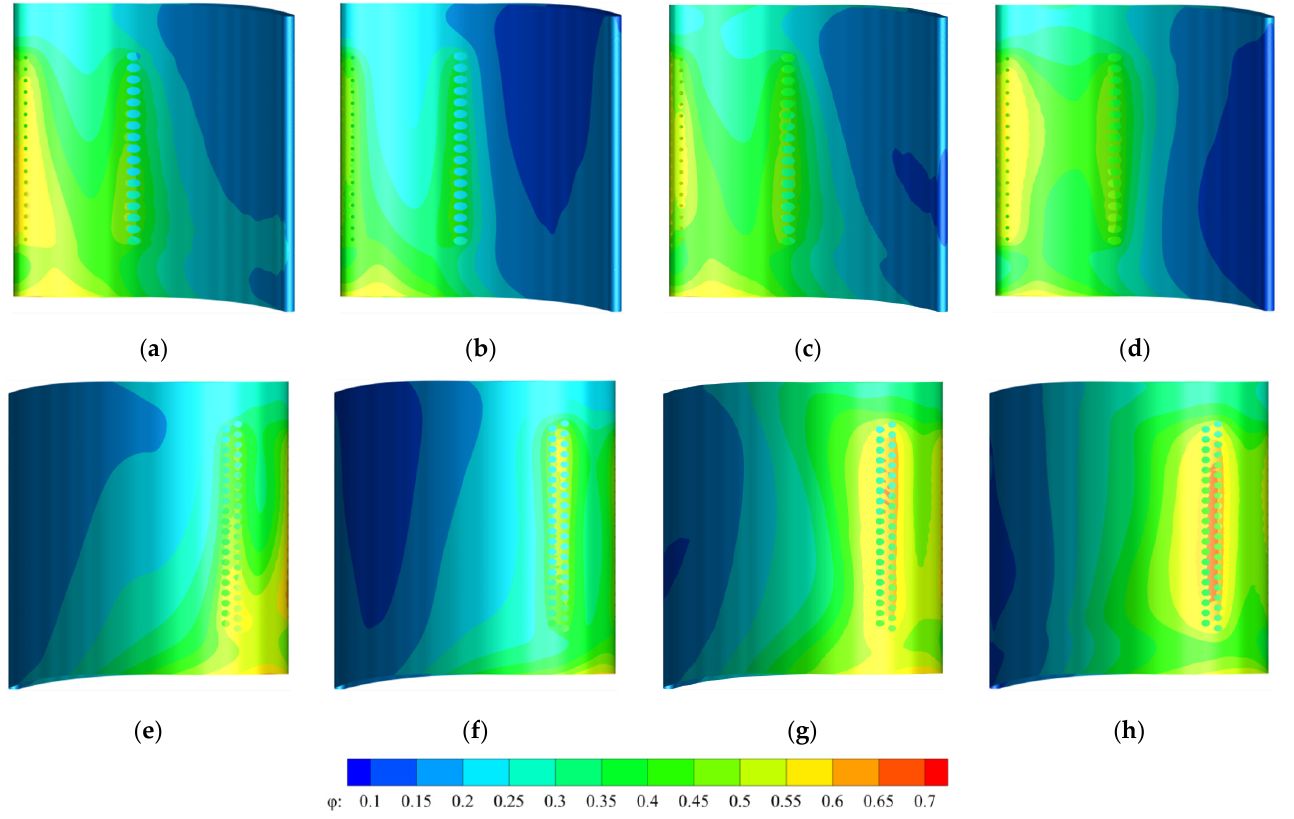
Figure 13. The cooling effectiveness of the coated blade at different relative stator–rotor locations.